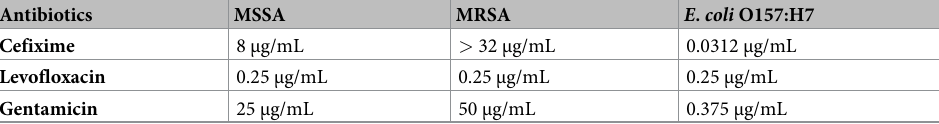
Table 1. MICs of the antibiotics determined for bacterial strains used in this